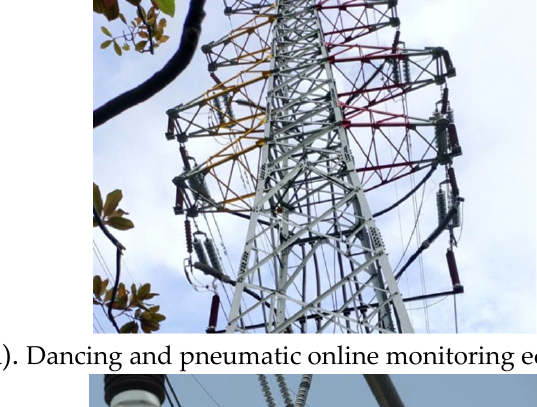
Table 6. Contrast table of CT-induced power extraction e ff ect. Reference